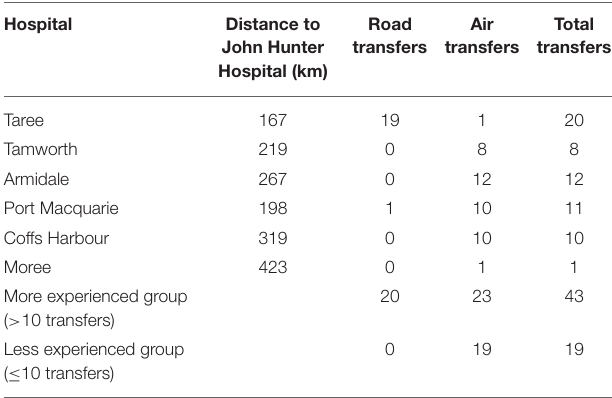
TABLE 2 | Distribution of transfers for rural spoke